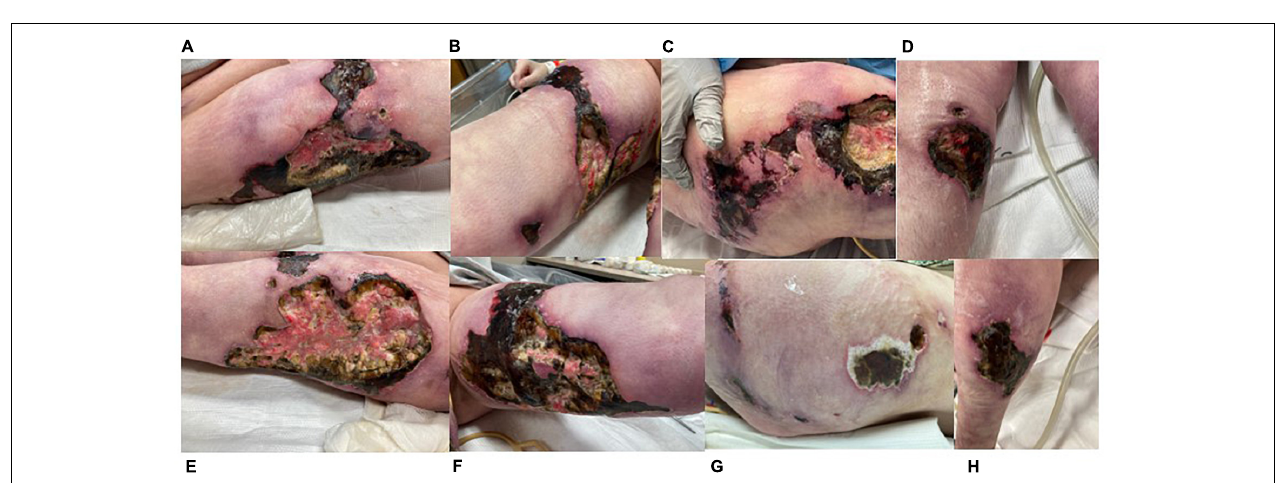
FIGURE 3 | Pathology images from incisional biopsy on left flank on 11/12/21 at 100x OM with (A) . Widespread pannicular thrombotic vasculopathy with ischemic pannicular necrosis (H&E) (B) . Negative for calcification on Von Kossa histochemistry with (C) . A single subcutaneous arteriole with mural calcification at the biopsy base (H&E). (D) Pathology image from incisional biopsy 12/1/21 at 100x OM with H&E showing adipocyte calcification.